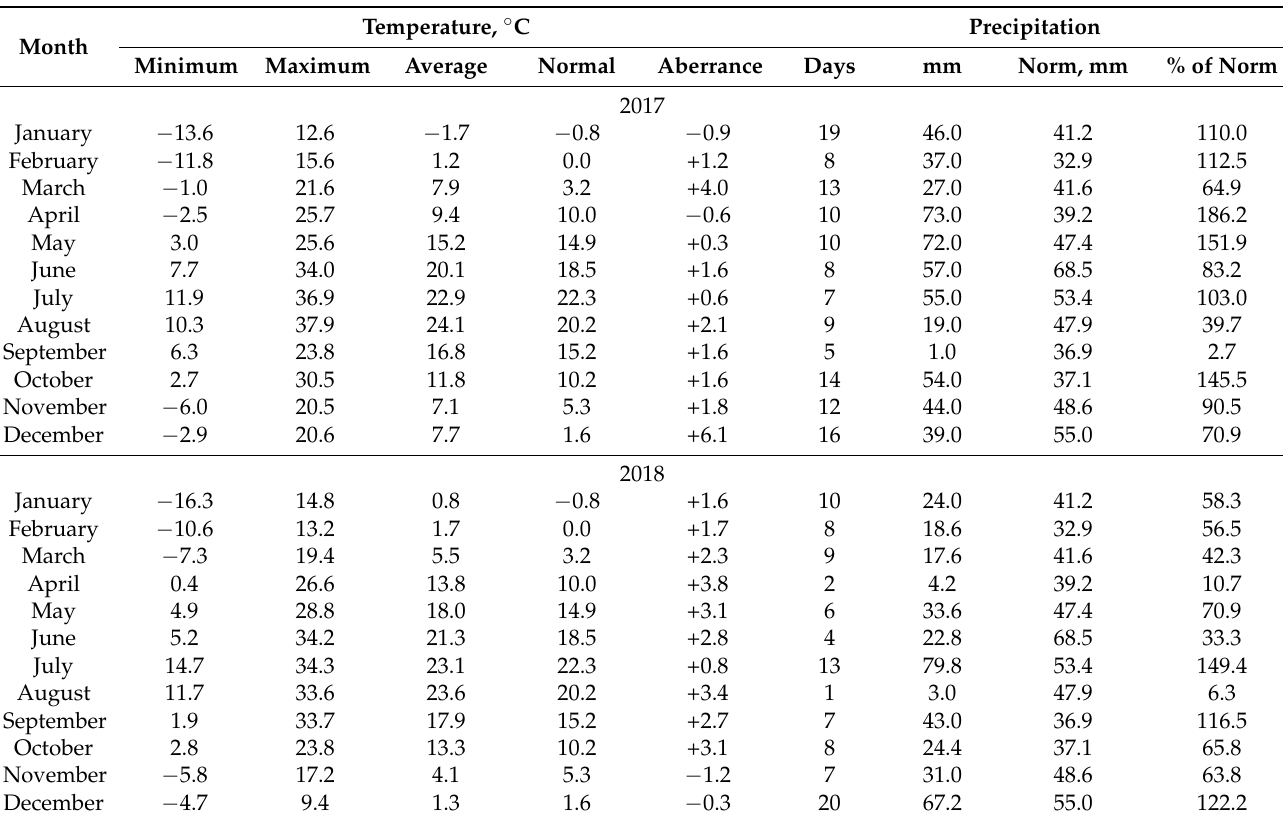
Table 1. Meteorological conditions of the study